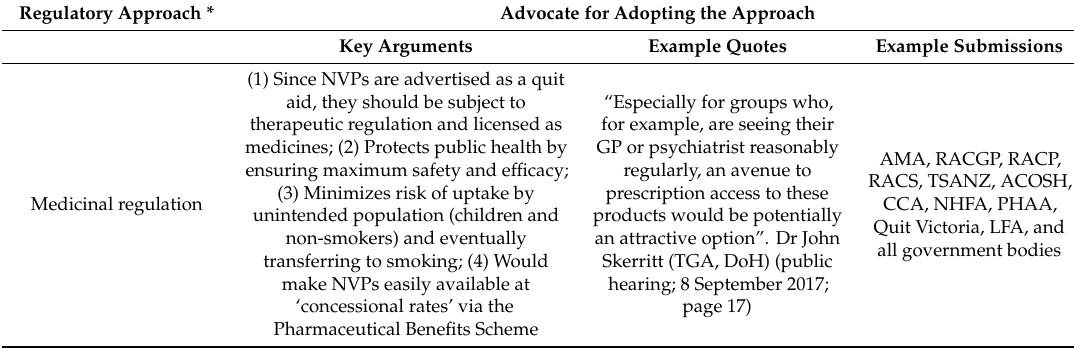
Table 2. Arguments made for adopting various regulatory approaches for NVPs and example quotes. Regulatory Approach